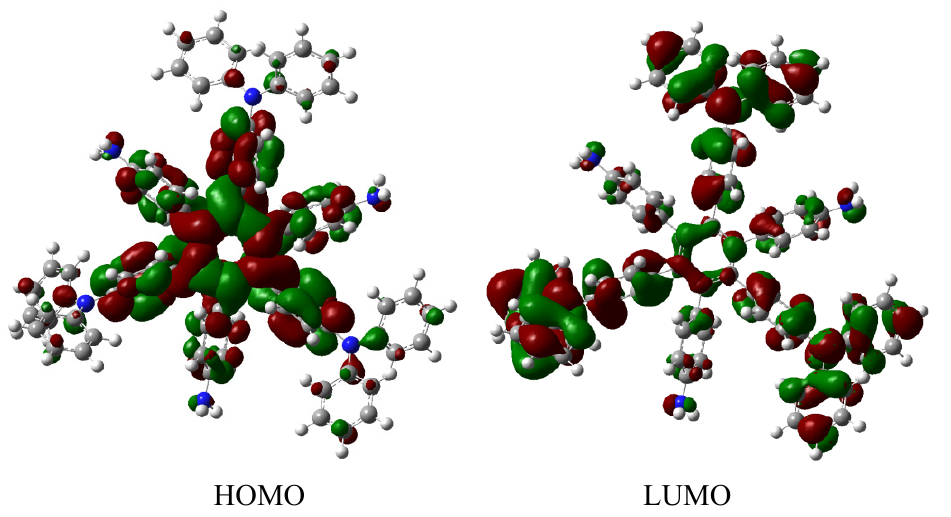
Figure 13. Frontier molecular orbitals for HAB6